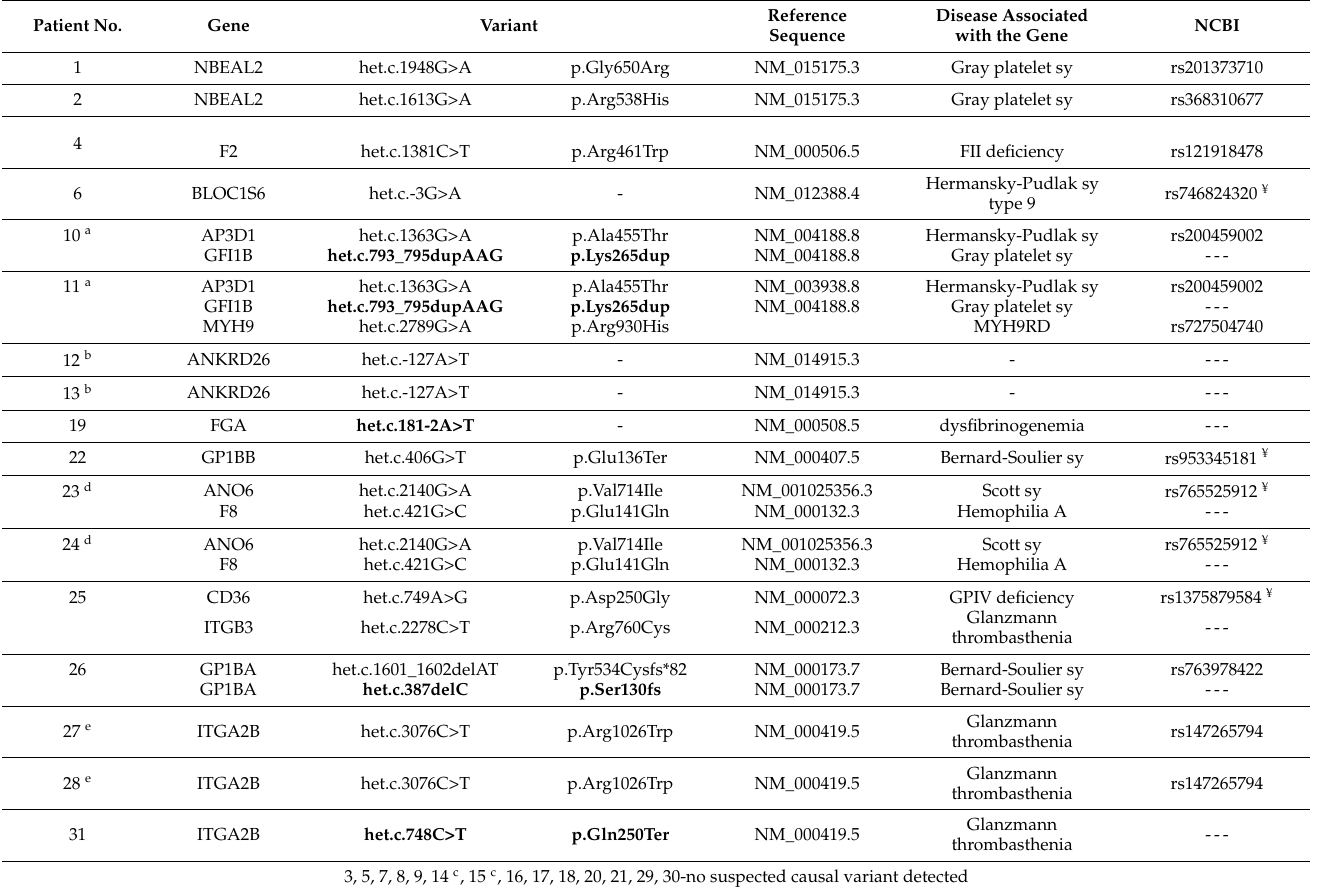
Table 5. NGS results of